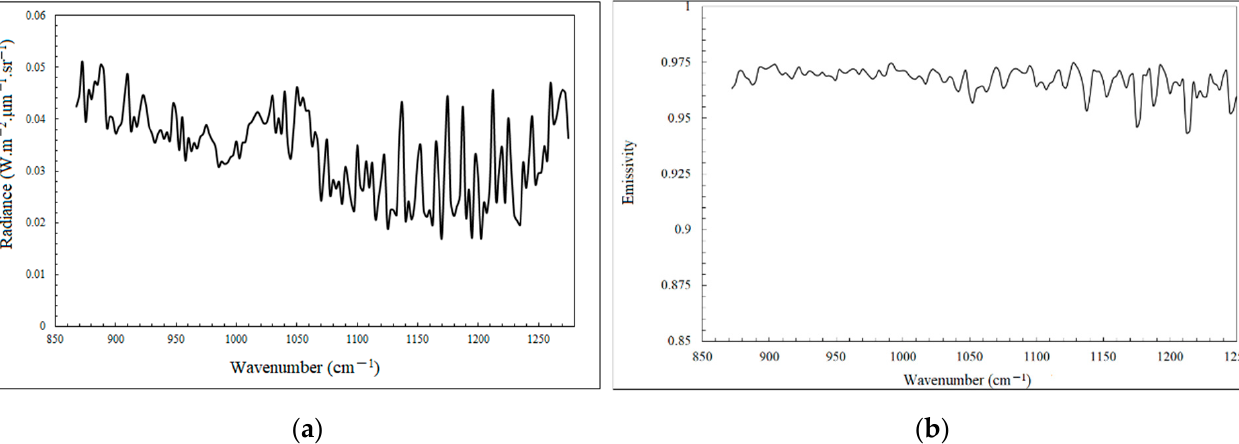
Figure 14. Results of emissivity retrieval and the down-welling radiance. ( a ) is the d own-welling radiance retrieved from the gold-plate, and ( b ) the emissivity of Haplophyllum dauricum.